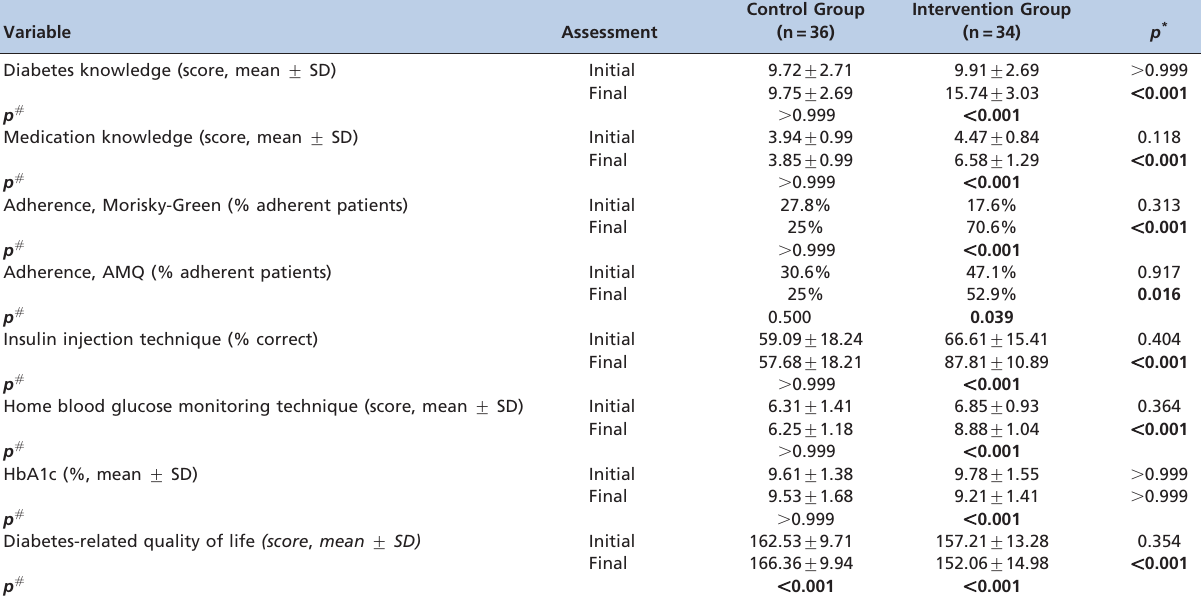
Table 2 - Outcome changes from baseline in the control and intervention groups.